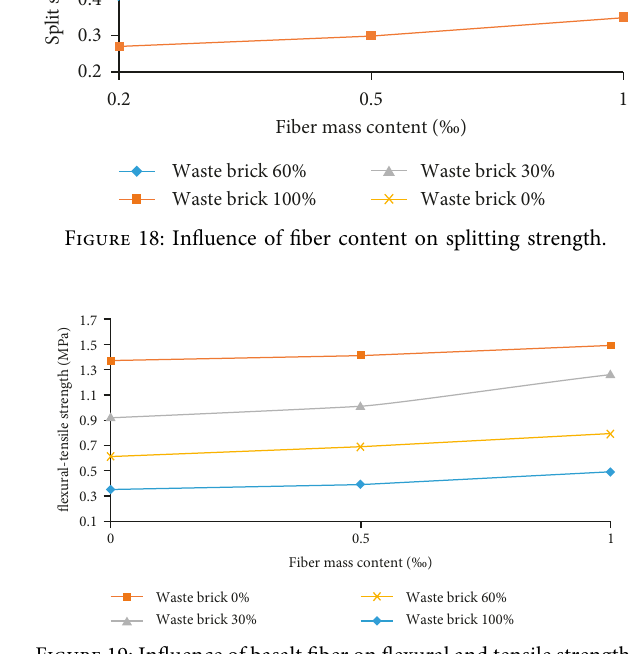
Figure 19: Influence of basalt fiber on flexural and tensile